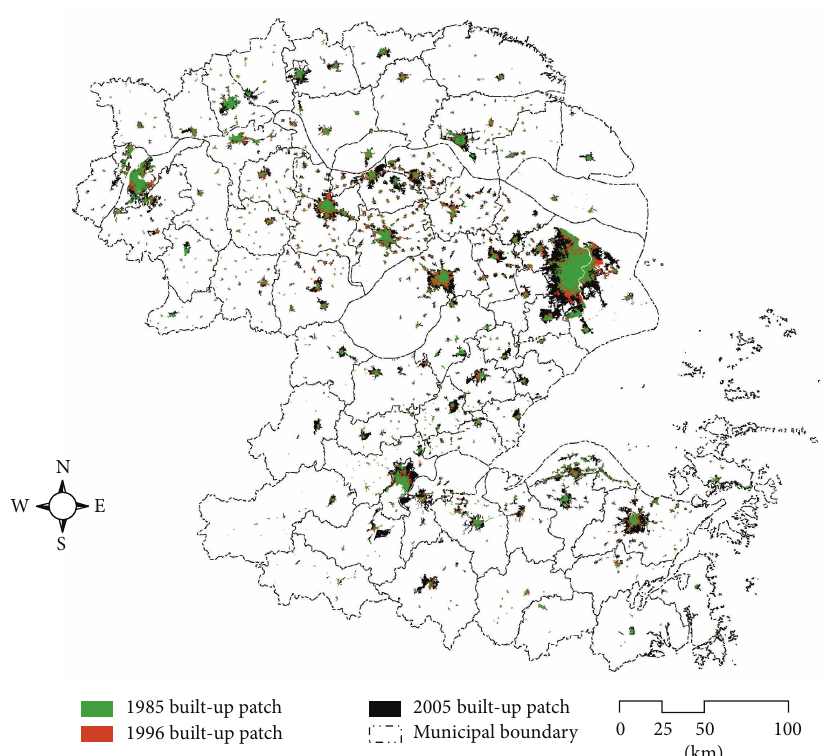
Figure 1: A sketch map of the 68 cities and towns in Yangtze River Delta, China